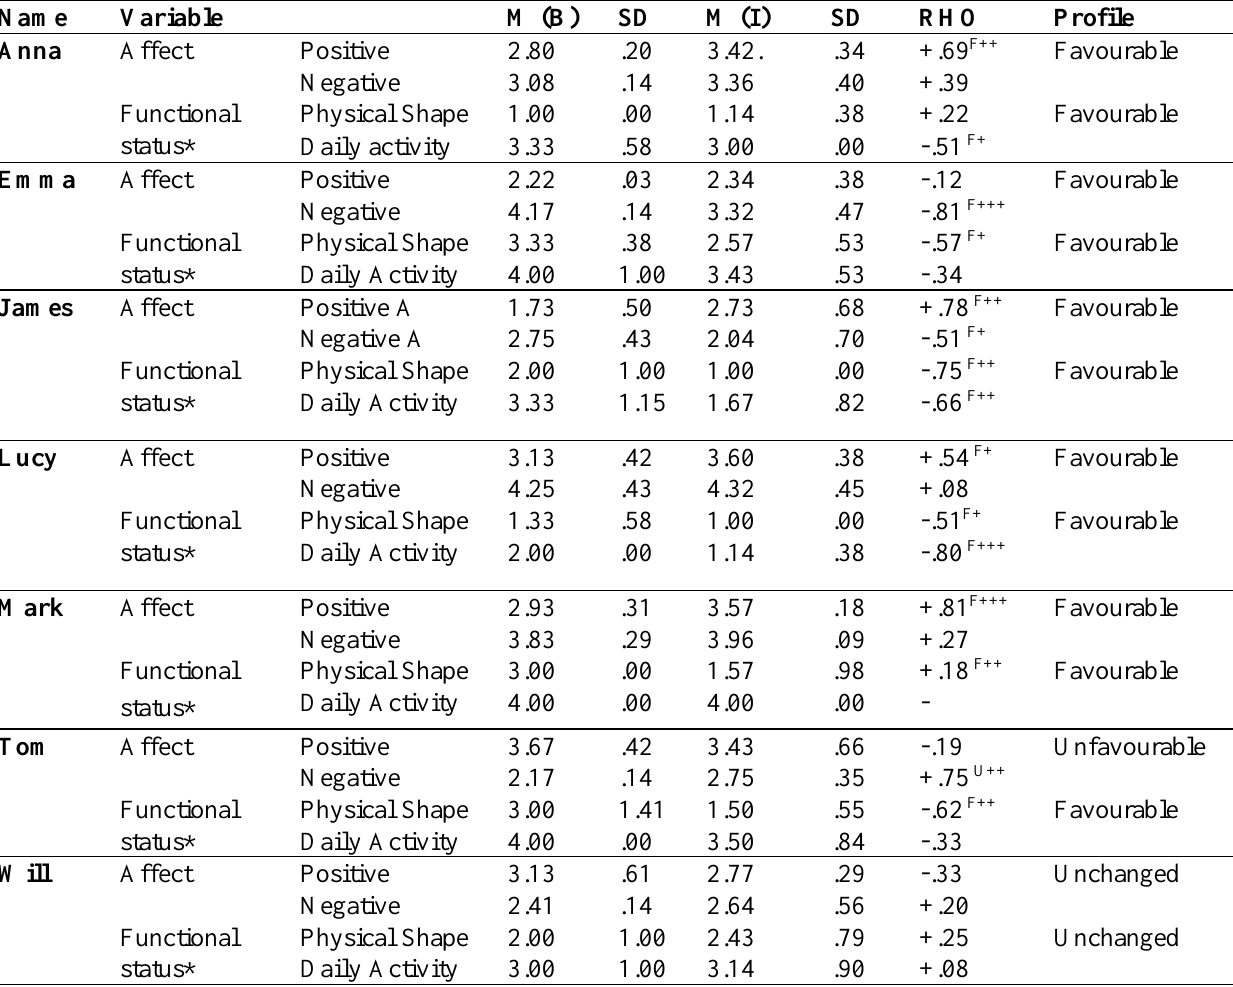
Table 4 . Simulation Modelling Analyses results for Functional status* at baseline and